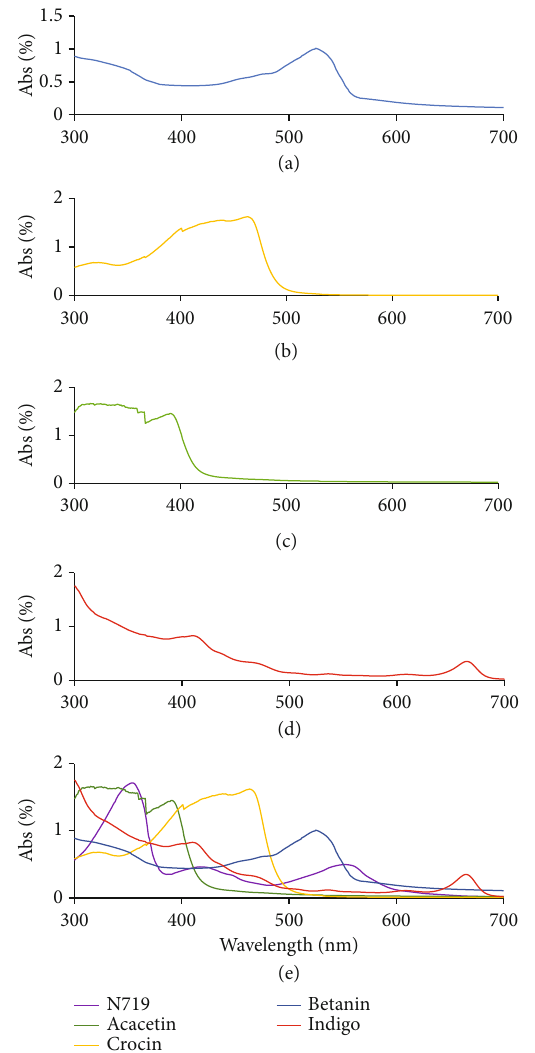
Figure 2: The UV-visible spectra of (a) betanin, (b) crocin, (c) acacetin, (d) indigo, and (e) the fi ve dyes